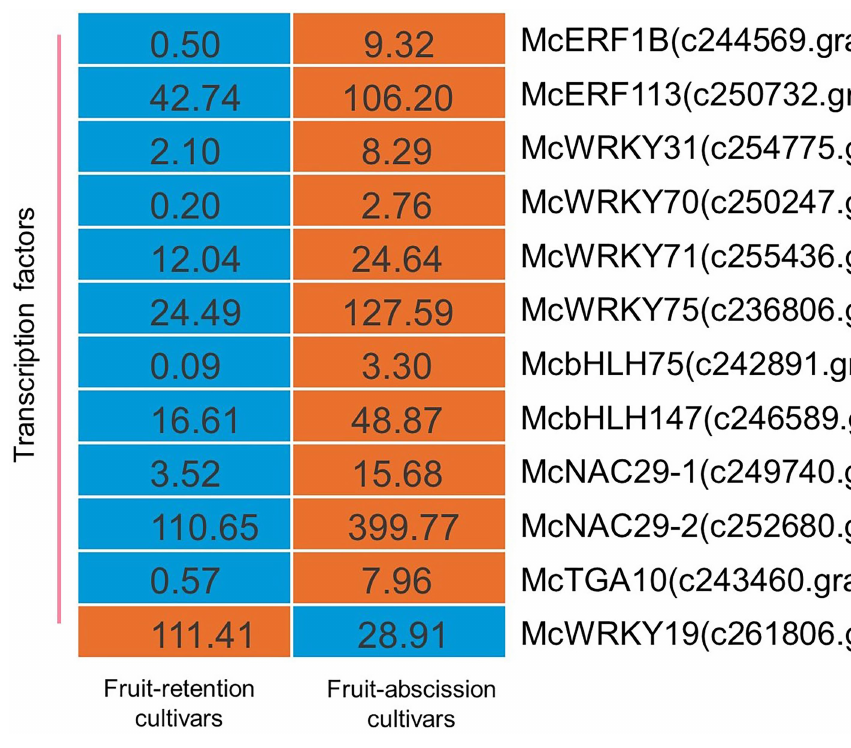
FIGURE 4 Schematics of biosynthesis differential transcript profiles of hormone metabolism-related genes and TFs. Genes up- or downregulated in all stages in fruit-retention and -abscission cultivars are denoted by orange and blue,